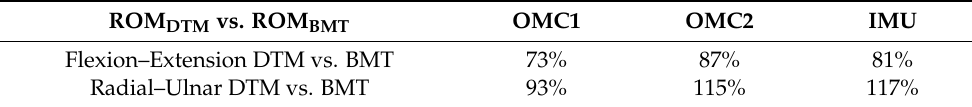
Table 3. Proportion between the maximum ROM BMT in the anatomical planes (flexion–extension and radial–ulnar deviation) and the ROM during the DTM.